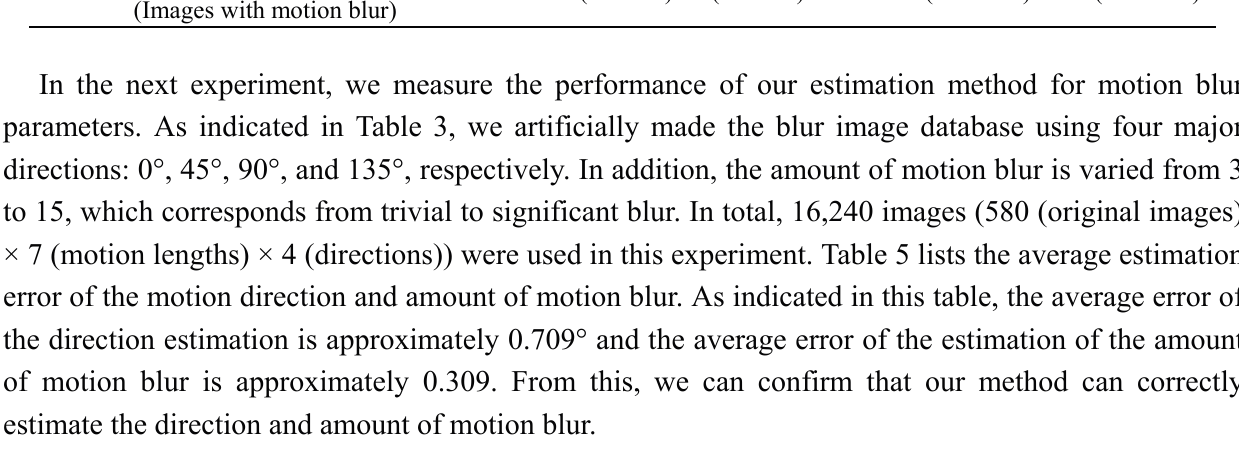
Table 5. Estimation errors of motion blur parameters using entire motion blur database.